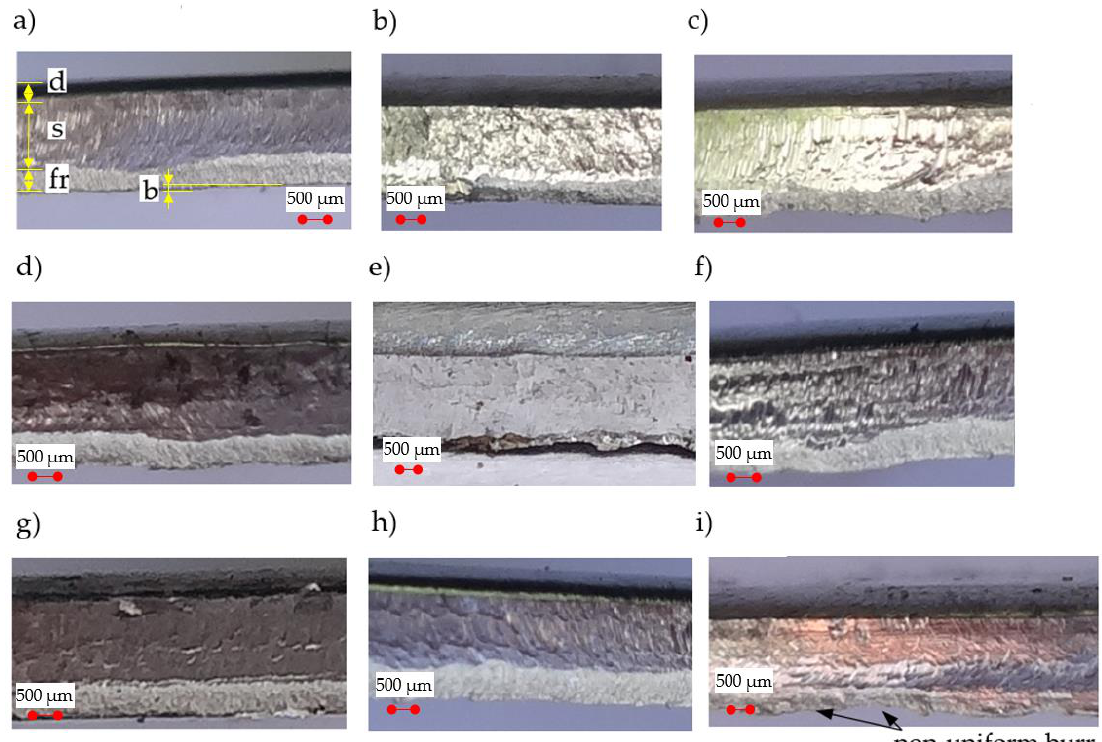
Figure 7. Characteristic features of the obtained sheared edges: ( a ) v = 7 m / min, h c = 0.05 mm, ( b ) v = 27 m / min, h c = 0.05 mm, ( c ) v = 7 m / min, h c = 0.13 mm, ( d ) v = 27 m / min, h c = 0.13 mm, ( e ) v = 3 m / min, h c = 0.09 mm, ( f ) v = 32 m / min, h c = 0.09 mm, ( g ) v = 17 m / min, h c = 0.03 mm, ( h ) v = 17 m / min, h c = 0.15 mm, ( i ) v = 17 m / min, h c = 0.09 mm.